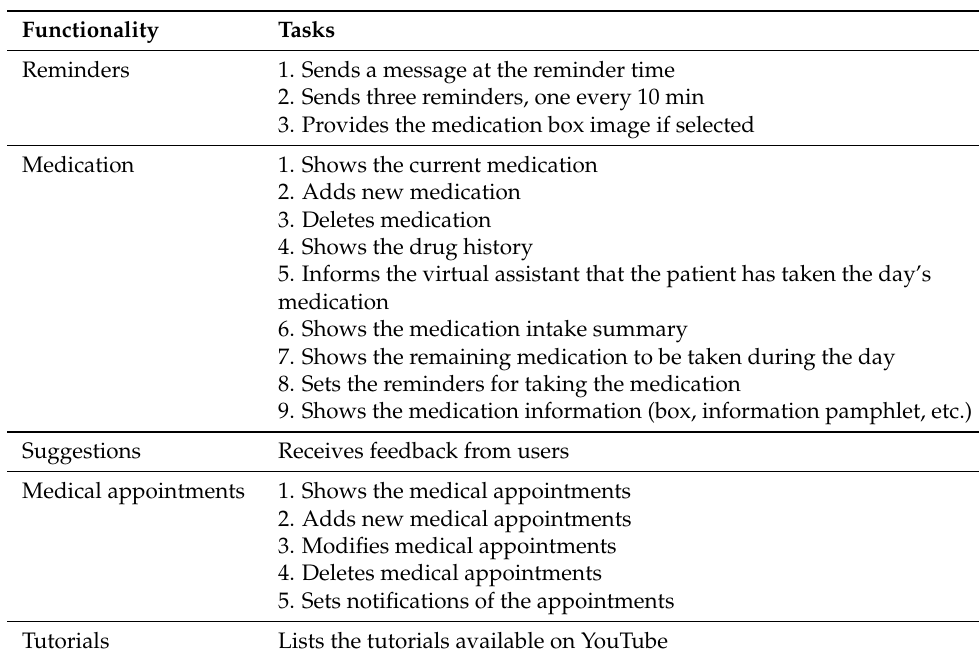
Table 1. Description of the functionalities used in the